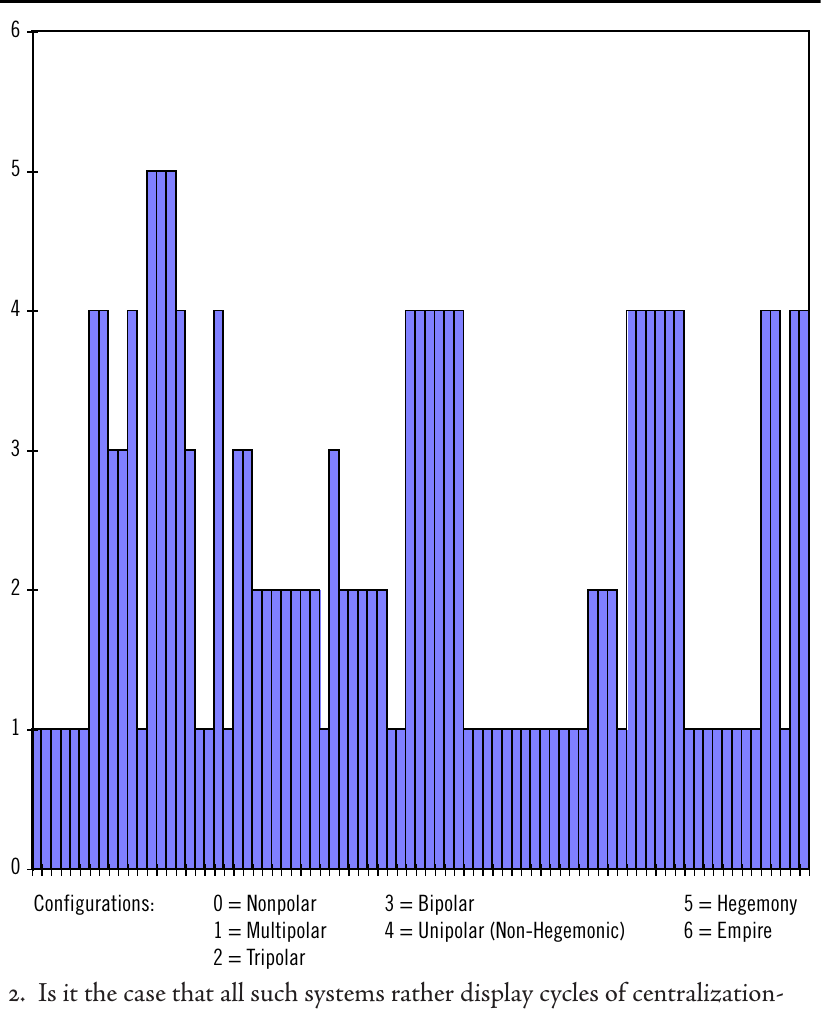
Figure 14 – Distribution of Central System Power Structures,